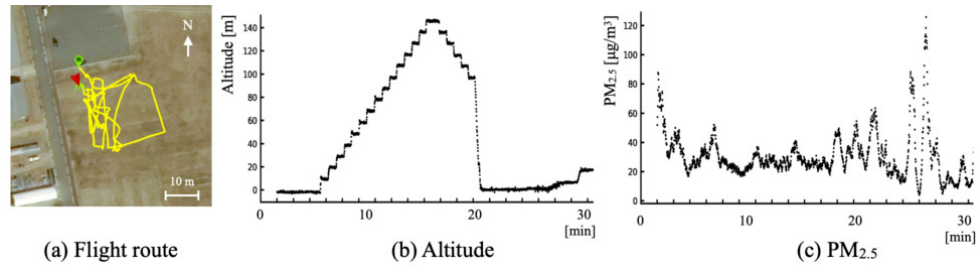
Figure 21. Flight measurement example of obtained signals from three key sensors.